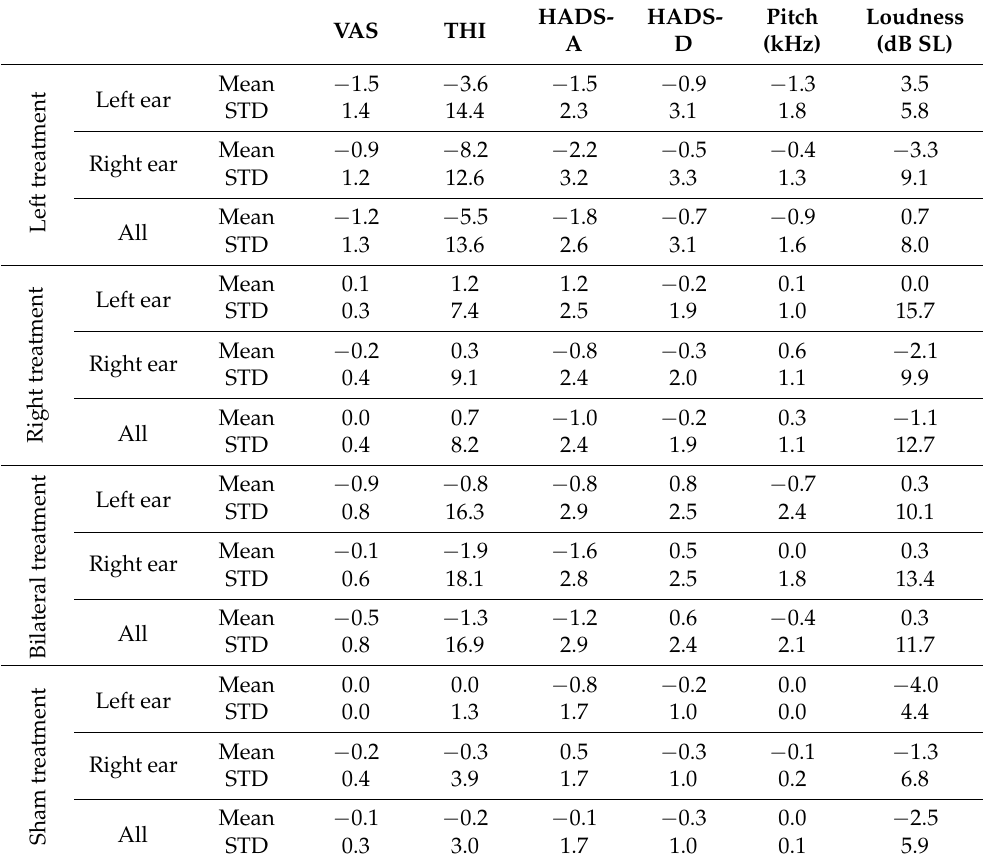
Table 3. Mean change and standard deviation between pre- and post-treatment outcome measures for each tinnitus ear (“Left ear”, “Right ear”) and across tinnitus ears (“All”) within the Left, Right, Bilateral, and Sham treatment